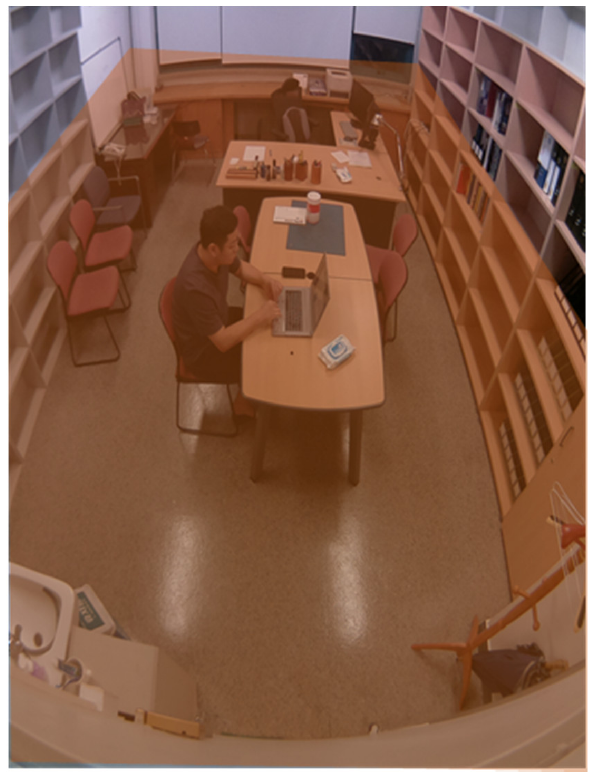
Figure 7. IR array sensor detecting area.